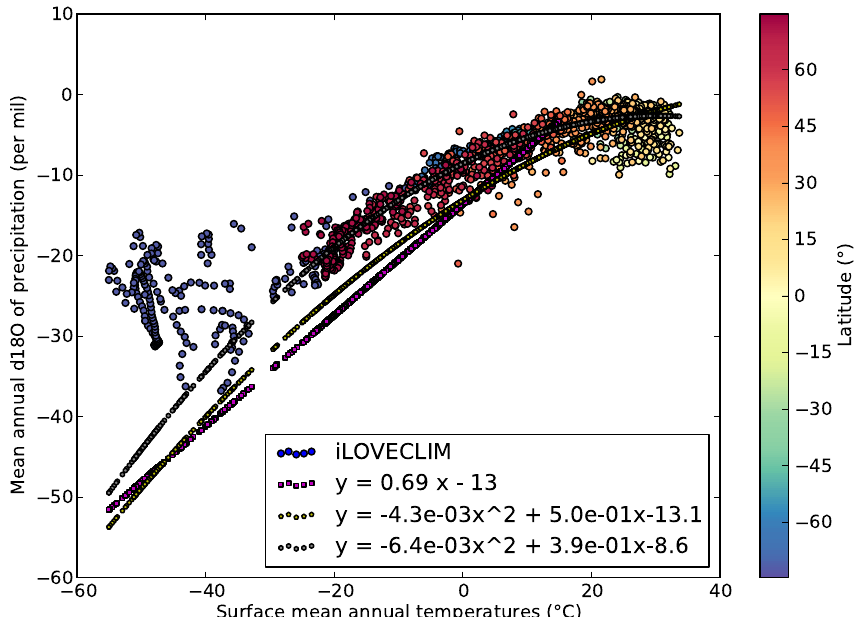
Fig. 3. Annual δ 18 O – Temperature relationship in i LOVECLIM compared to the original regression from Dansgaard (1964). Coloured dots are from the model simulation, coloured after their latitude, given on the scale to the right ; grey dots is the fitted second-order polynomial to the model data for temperature above − 30 ◦ C; magenta dots are constructed from the temperature data in i LOVECLIM, using the regression from Dansgaard (1964); yellow dots are constructed from the temperature data in i LOVECLIM using a second order polynomial fitted to the GNIP dataset. R 2 values for the fit to the i LOVECLIM model is 0 . 911 (grey dots); R 2 values for the fit to the GNIP data is 0 . 977 (yellow